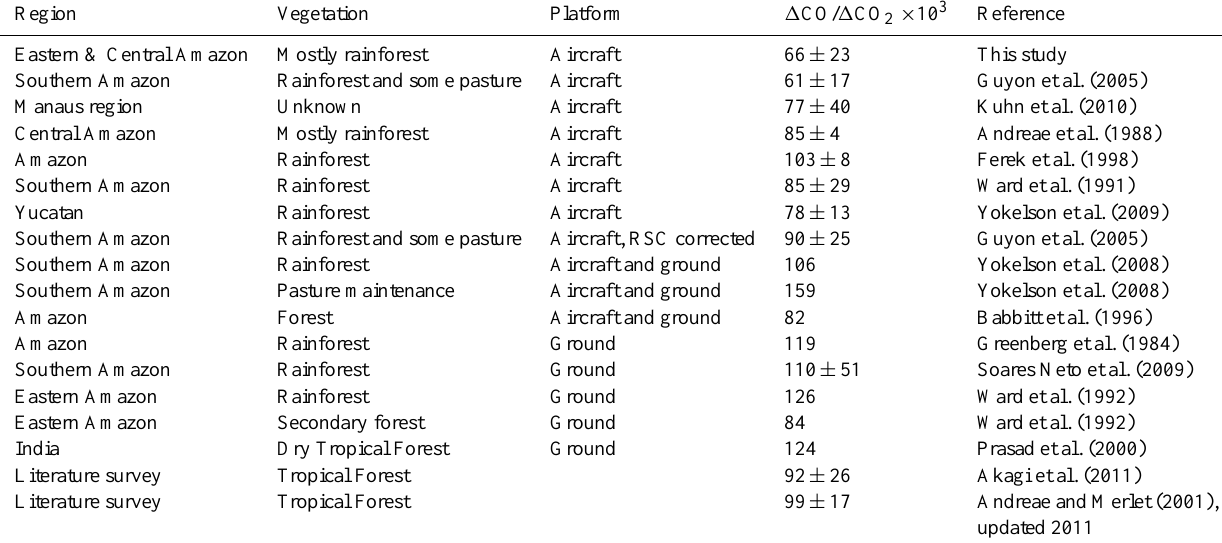
Table 2. Comparison of emission ratios 1 CO/ 1 CO 2 measured during BARCA with literature